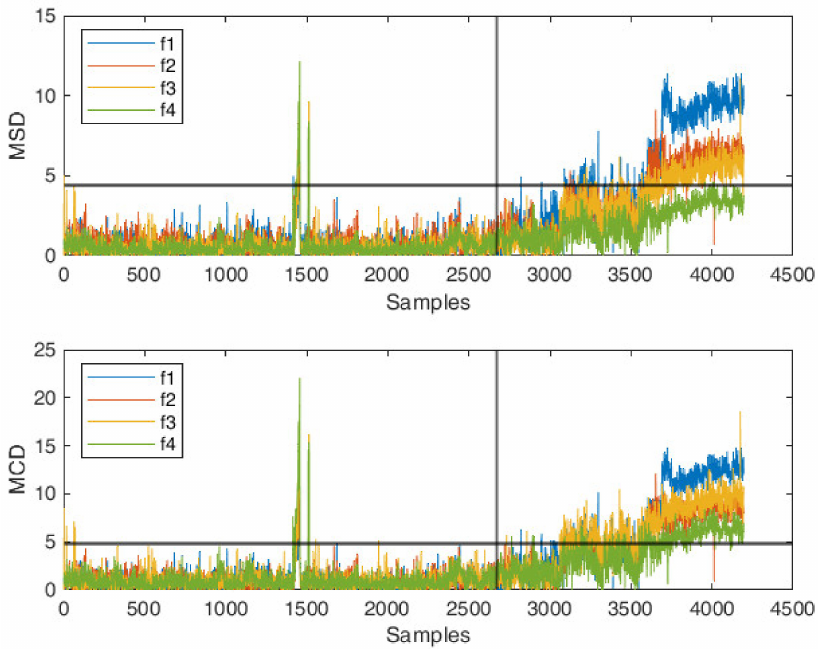
Figure 6. Comparison between univariate MSD and MCD distances for the four natural frequencies.